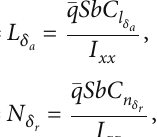
Table 6. The desired damping ratio and natural frequency for the Dutch-roll mode are 0.8 and 5 rad/s, respectively. In addition, the closed-loop spiral mode is set to -6 here. This is in sharp contrast to the conventional conception that the spiral mode should be close to zero. To avoid the coupling e ff ect of the dominant poles of the error integral modes, the closed-loop spiral mode should be placed far away from the integral modes.